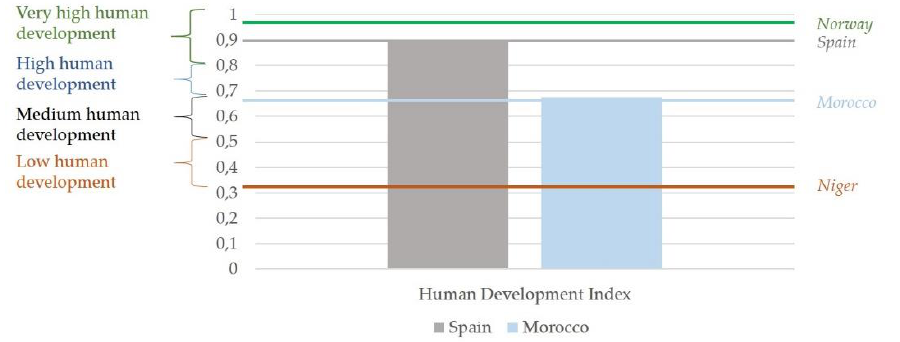
Figure 1. Score obtained in each country according to the Human Development Report published in 2019.